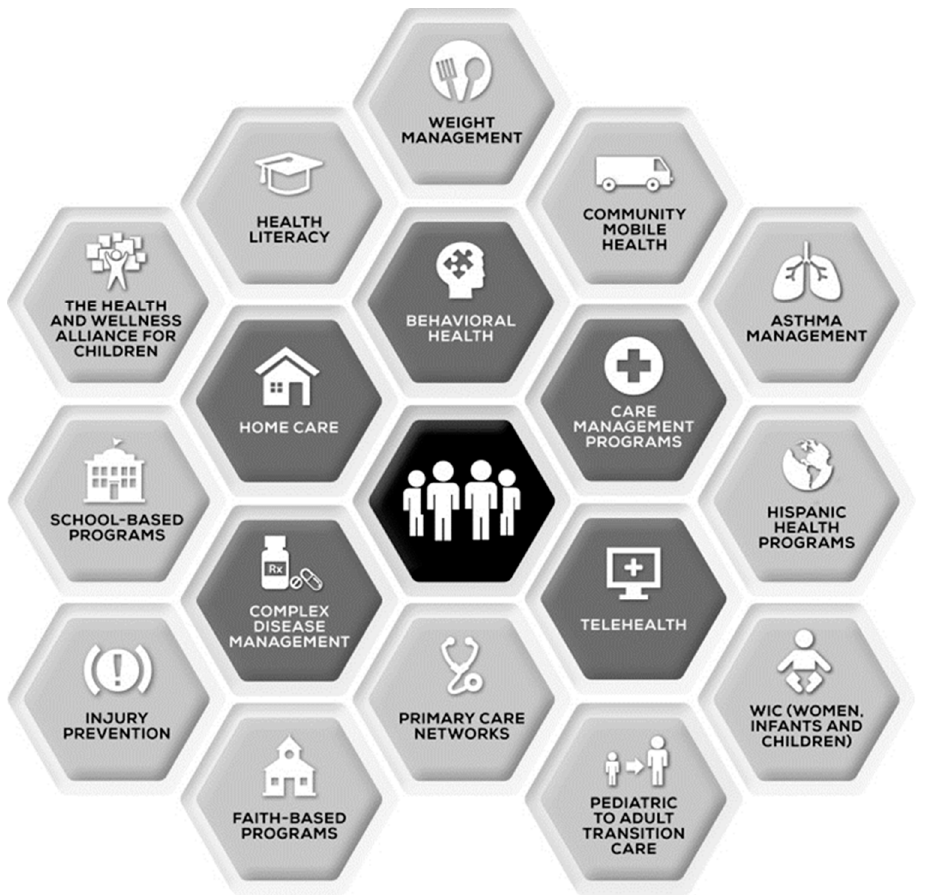
Figure 4. Population health (PH) capabilities [83].